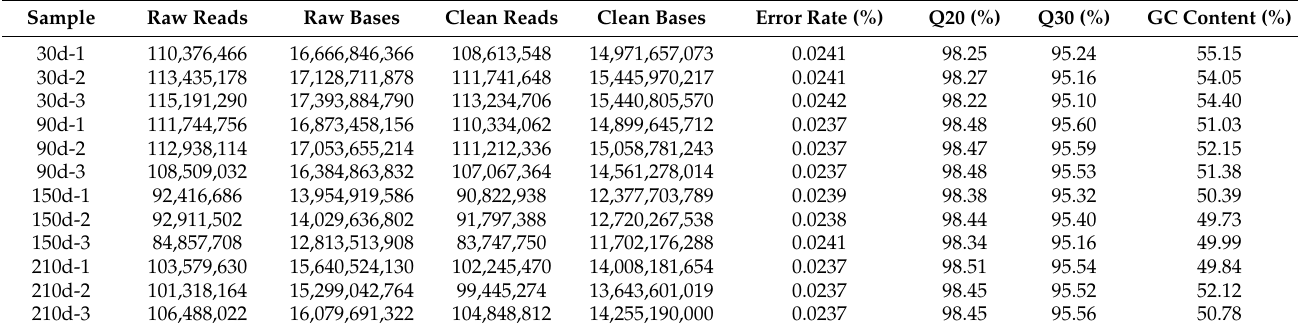
Table 2. Statistics of raw and clean reads after quality control.